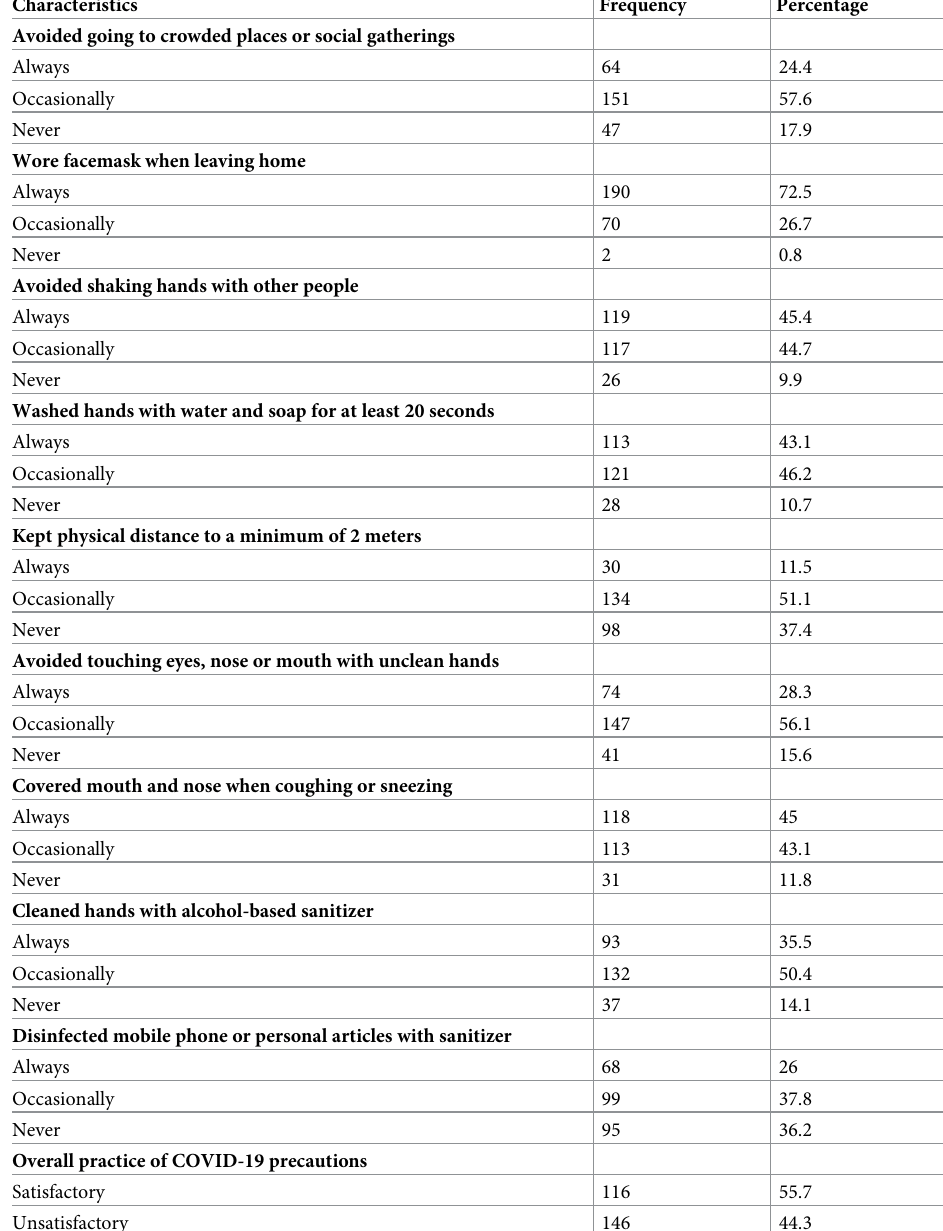
Table 5. COVID-19 precautionary practices among respondents in the preceding two weeks.